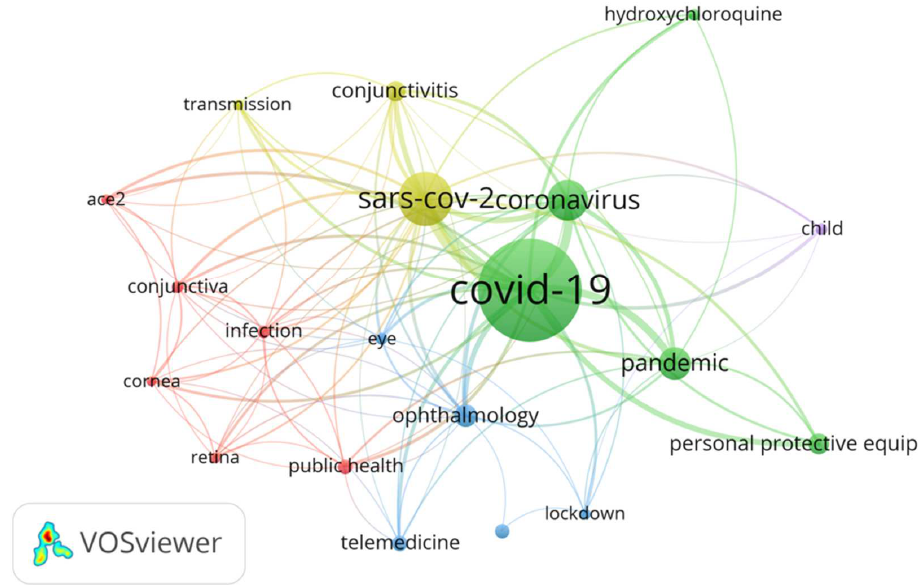
Figure 7. Network visualization of the co-occurrences relations between authors’ keywords. The keywords with minimum occurrences (20) are shown on the map. Label size is an indication of the frequency of each keyword’s occurrence, while different colors represent word clusters. The keywords of the same cluster are often listed together. For example: conjunctiva, infection and public health are shown with the same color because they are closely related and usually co-occur.